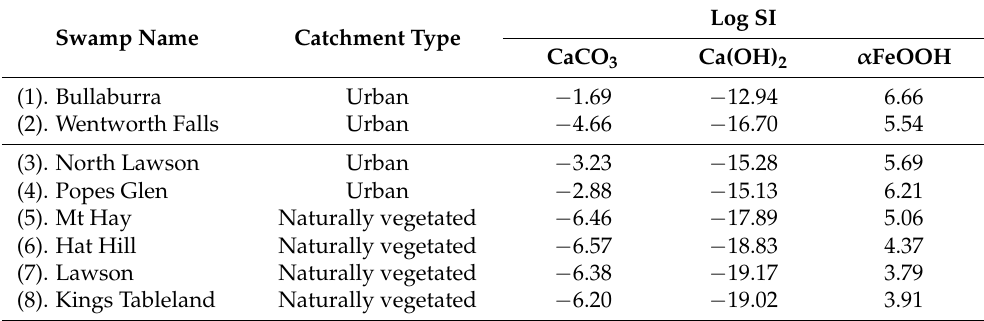
Table 5. Saturation Index (SI) in log for calcite (CaCO 3 ), portlandite (Ca(OH) 2 ) and goethite ( α FeOOH) in water from urban ( n = 4) and naturally vegetated ( n = 4) Temperate Highland Peat Swamps on Sandstone (THPSS)